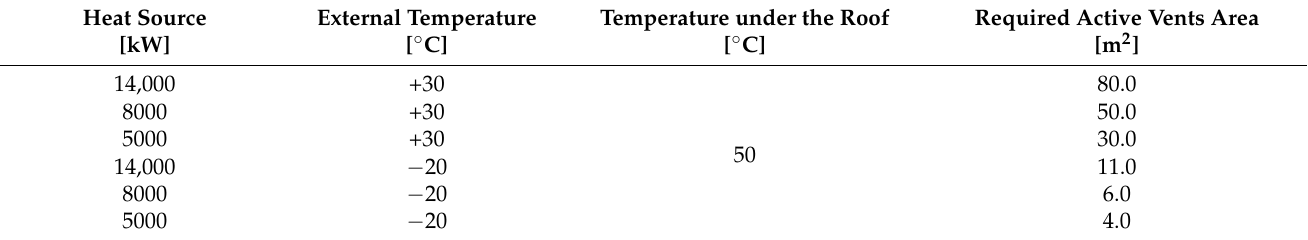
Table 2. The required vents area for keeping under the boiler house’s roof temperature below 50 ◦ C in standard